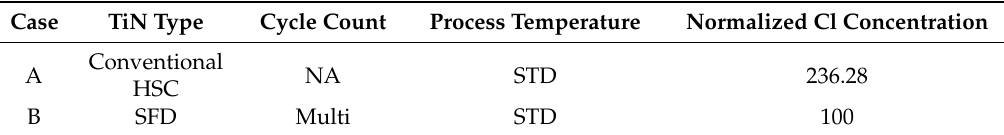
Table 1. Normalized chlorine concentration in TiN films by SIMS analysis for different TiN